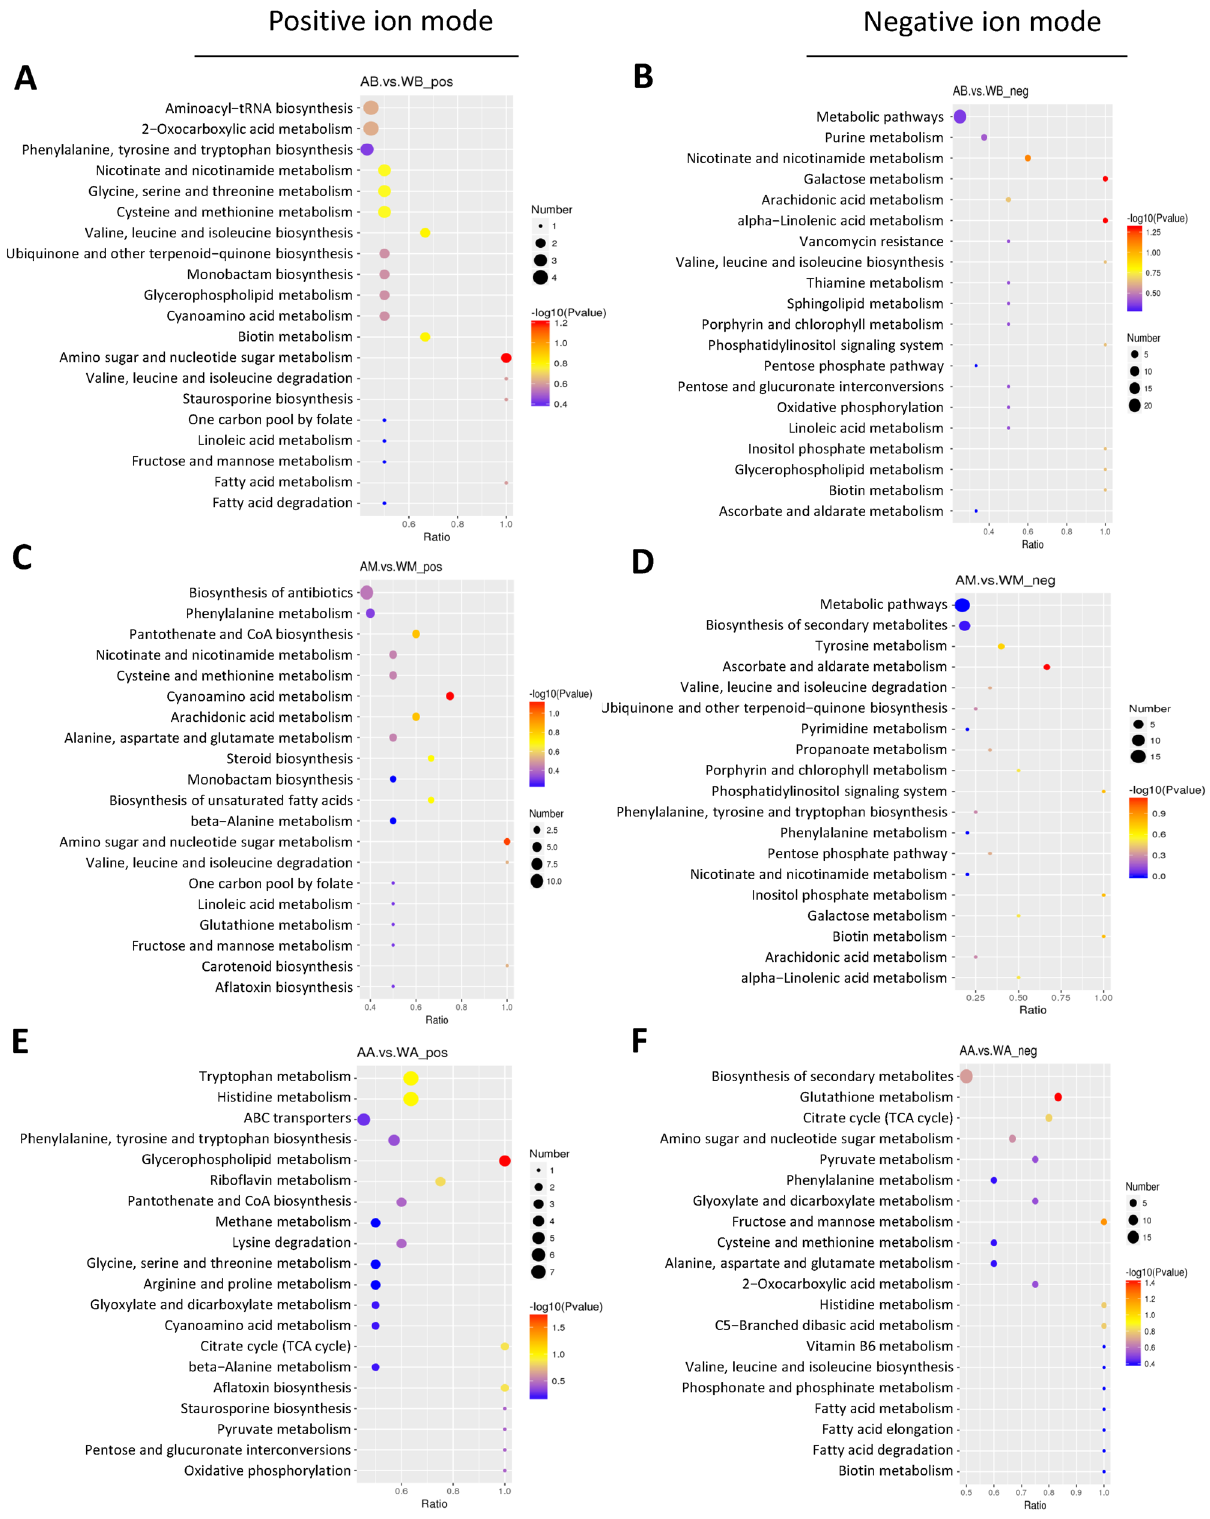
Figure 5. KEGG enrichment bubble diagram of metabolites of cultivated and wild Inonotus hispidus in different growth periods. ( A ) AB vs. WB under the positive ion mode, ( B ) AB vs. WB under the negative ion mode, ( C ) AM vs. WM under the positive ion mode, ( D ) AM vs. WM under the negative ion mode, ( E ) AA vs. WA under the positive ion mode, ( F ) AA vs. WA under the negative ion mode. Note: AB, AM, and AA are samples of fruiting bodies of cultivated Inonotus hispidus in budding, mature and aging growth periods, respectively. WB, WM, and WA are samples of fruiting bodies of wild Inonotus hispidus in budding, mature and aging growth periods,